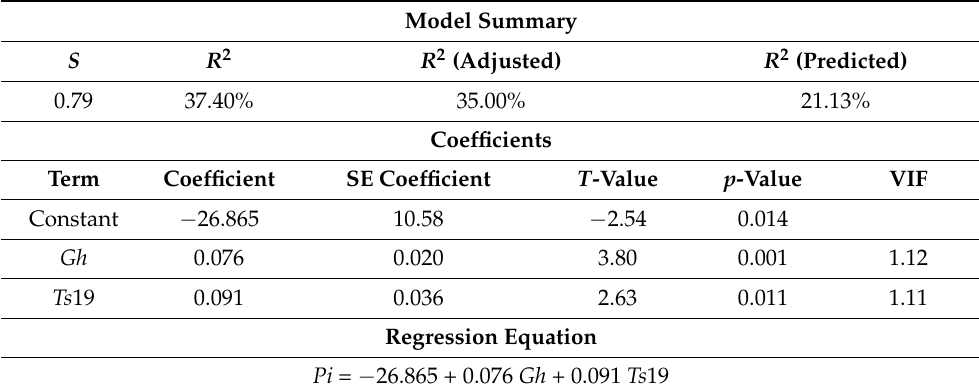
Table 1. Model summary for con-still (Model 1).